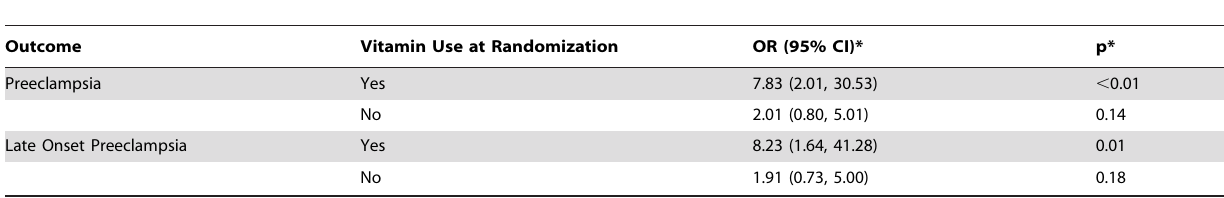
Table 4. Odds ratios for treatment effect in Hispanic Hp 2-2 women according to prenatal/multivitamin use at randomization.